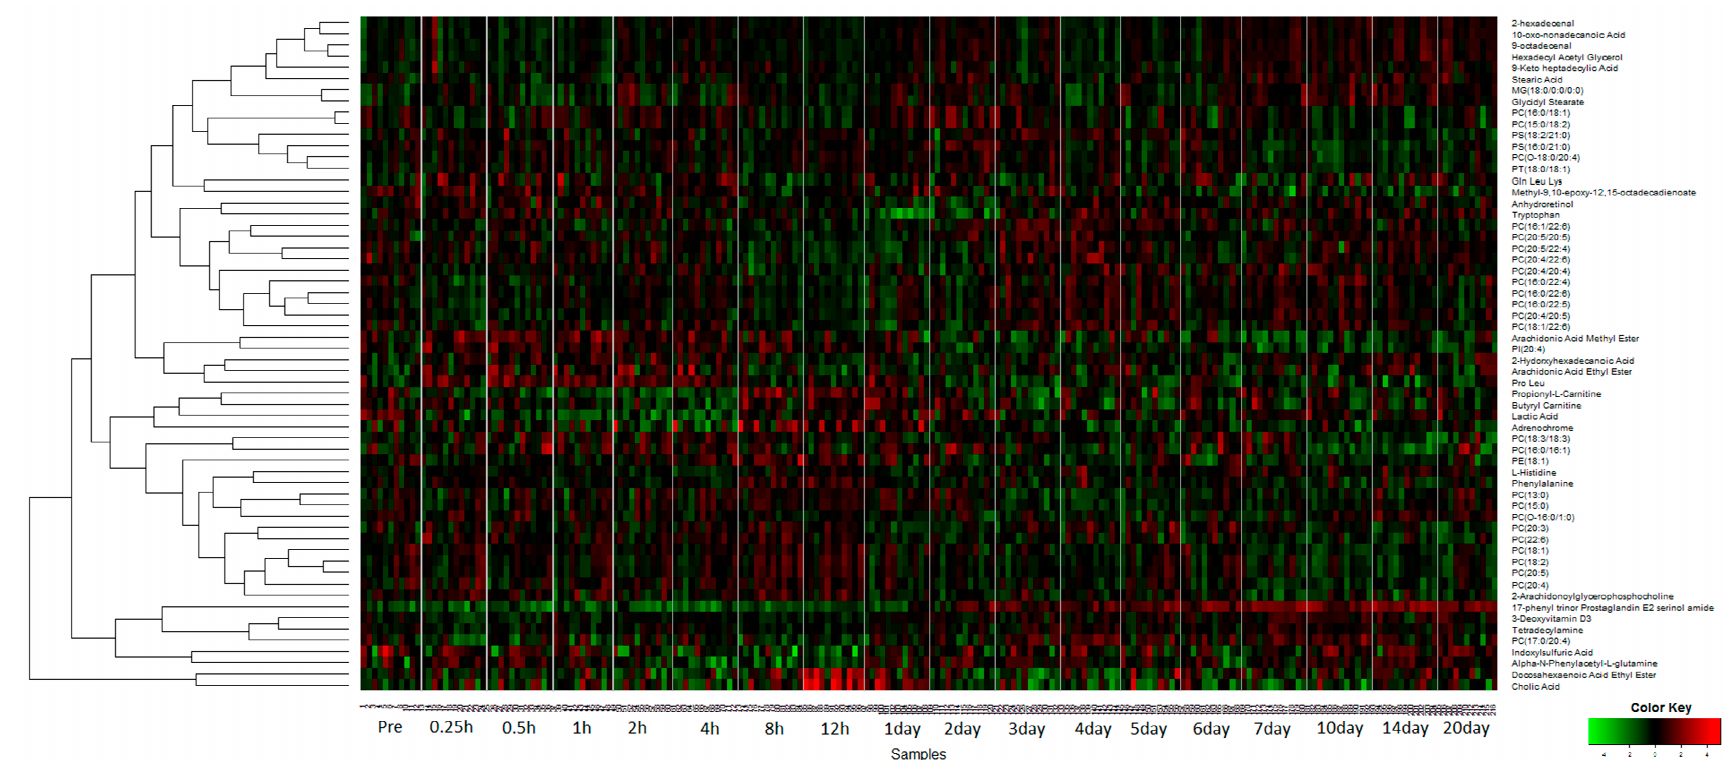
Figure 2. Heatmap illustration of validated metabolites showing transient changes in relative abundance. A total of 61 biomarkers with significant changes (adjusted p < 0.05) were validated by tandem mass spectrometry. Hierarchical clustering was used to visualize time and/or dose dependence upon GT3 administration.